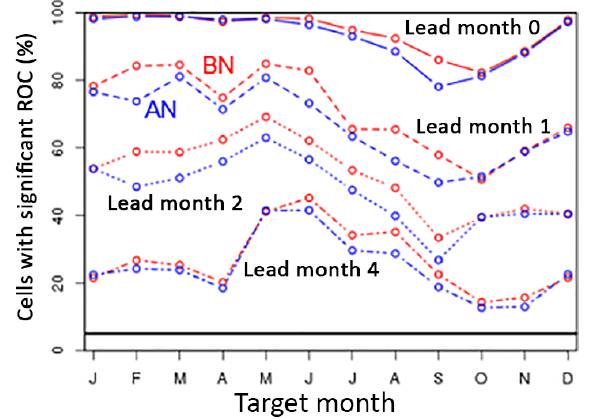
Figure 10. Skill of the run-off hindcasts in the below-normal (BN) tercile compared to the skill of the run-off hindcasts in the above- normal (AN) tercile. The plot depicts annual cycles of the fraction of cells with a significant ROC area for the two terciles and for 4 lead